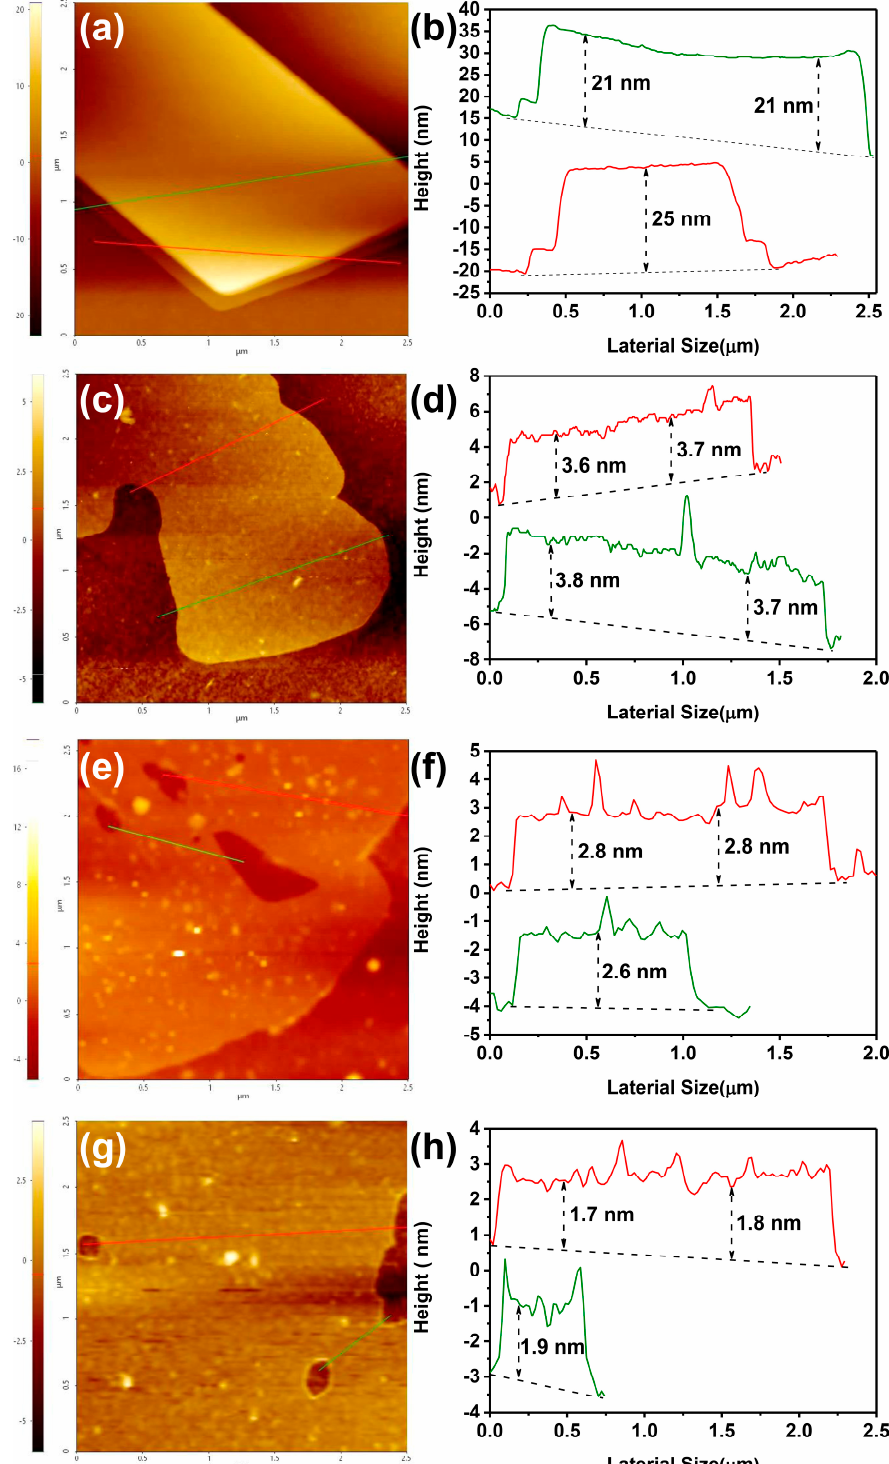
Figure 1. Atomic force microscopy (AFM) images (left side) and corresponding height profiles (right sides) of ( a , b ) pristine crystal graphite and the resulting graphite/3A-PCL composites at ( c , d ) 5/10, ( e , f ) 3/10 and ( g , h ) 1/10 blend ratios. The green and red profiles presented in ( b , d , f ) and ( h ) correspond with the green and red solid lines seen in the images of ( a , c , e , g ), respectively.